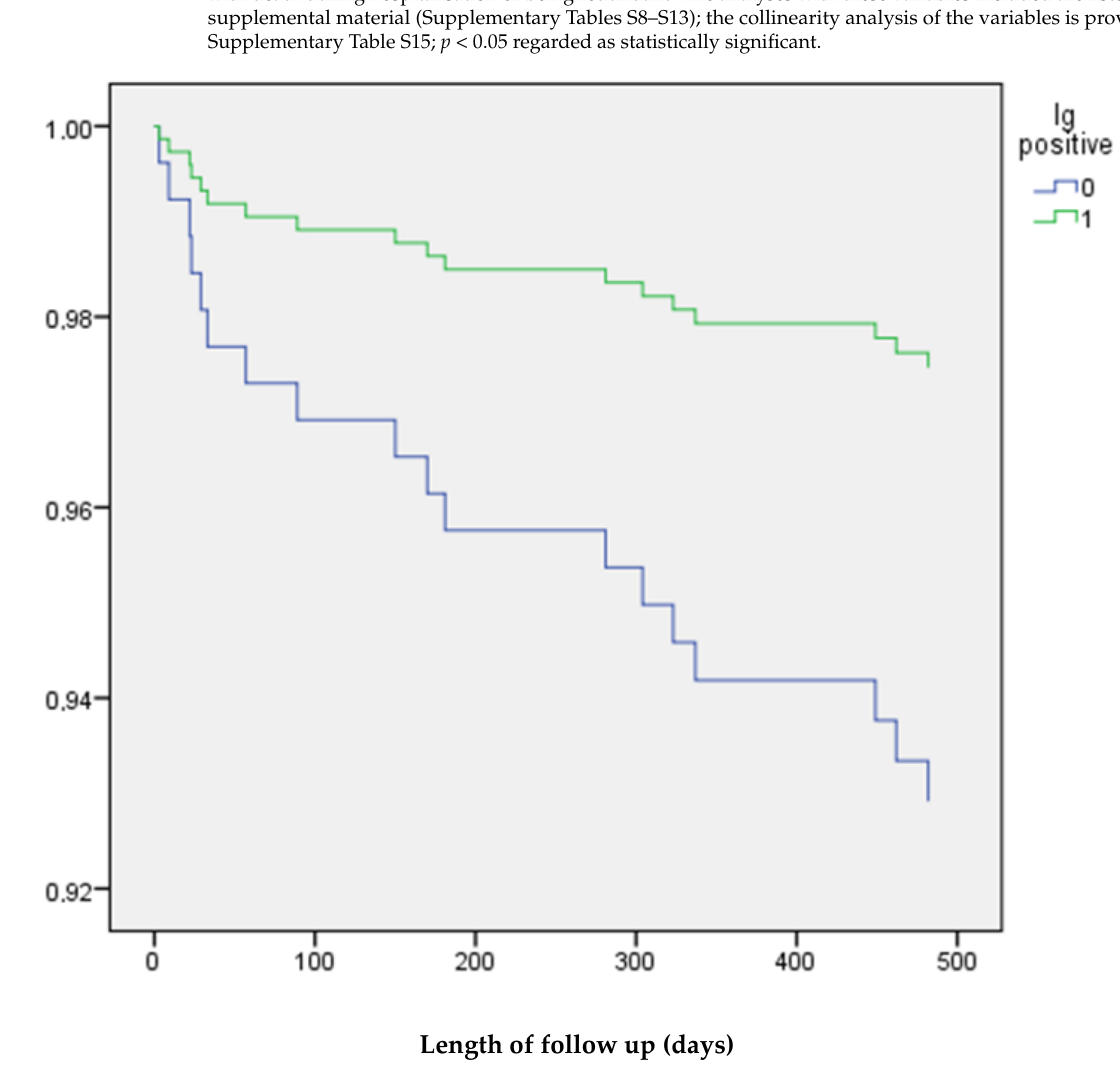
Figure 2. Cox regression of the association between anti-SARS-CoV-2 antibody status at the time of admission and survival after hospital discharge. Adjusted for age. Blue line: anti-SARS-CoV-2 immunoglobulin (Ig) negative; green line: anti-SARS-CoV-2 immunoglobulin (Ig) positive.